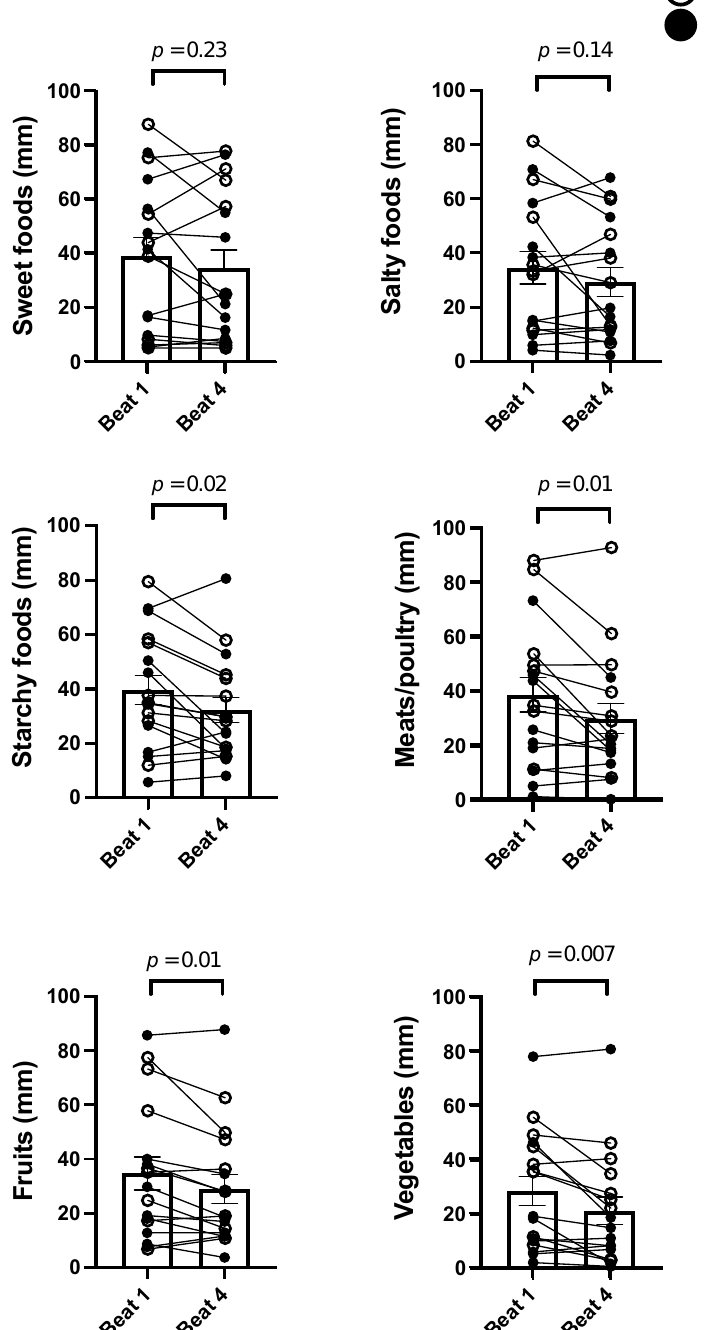
Figure 4. Acute and chronic impact of circadian disruption on food type preference. Data from the